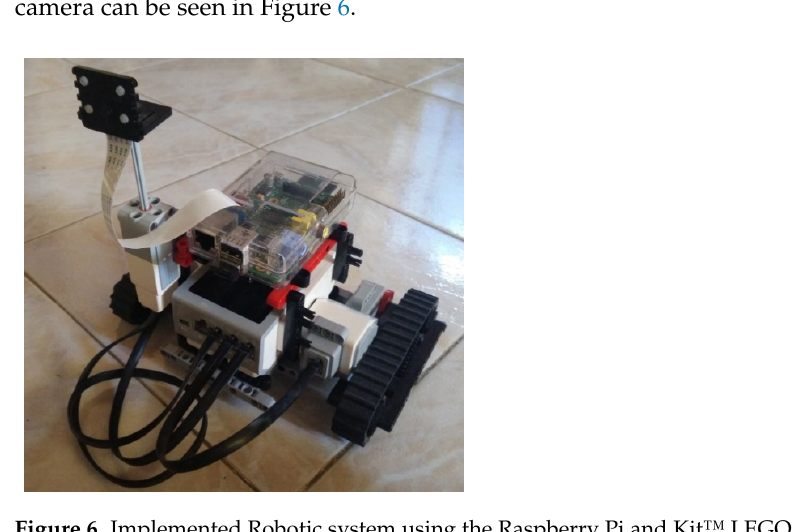
Figure 6. Implemented Robotic system using the Raspberry Pi and Kit™ LEGO Mindstorms robotic. Some simulations were running up to operate this robot using the controllers as shown in the next section.